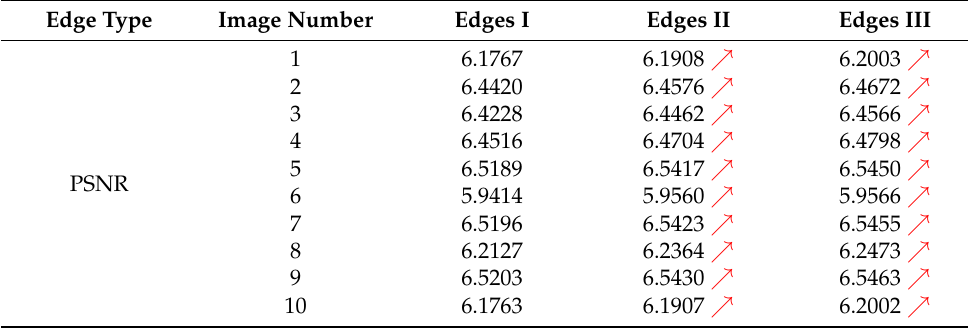
Table 3. The PSNR values of each type edge for randomly selected images.